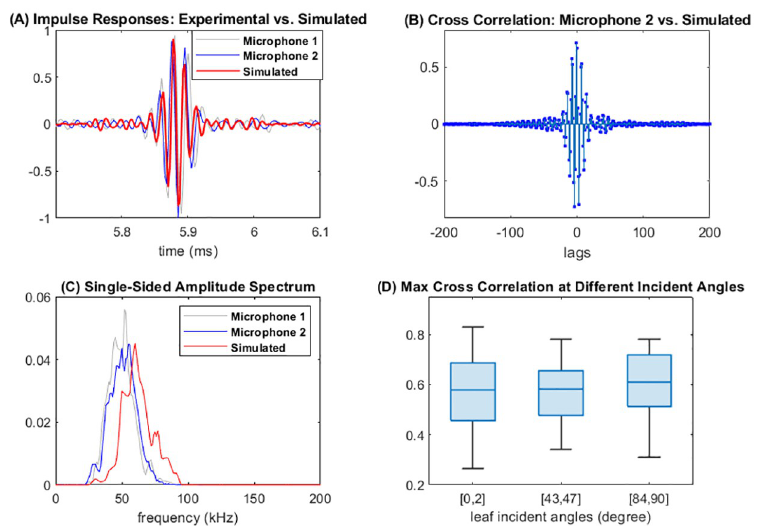
Fig 4. Comparison plots for one measurement. (A) Waveforms of impulse responses from the two microphones and simulation. (B) The normalized cross correlations between microphone 2 and simulated signal, plotted as a function of lags. Here, the lag refers to the number of phase shift positions. (C) Frequency domain comparison—single sided amplitude spectra for impulse responses from the two microphones and simulation. (D) Boxplots of the maximum absolute cross correlation at three different incident angle